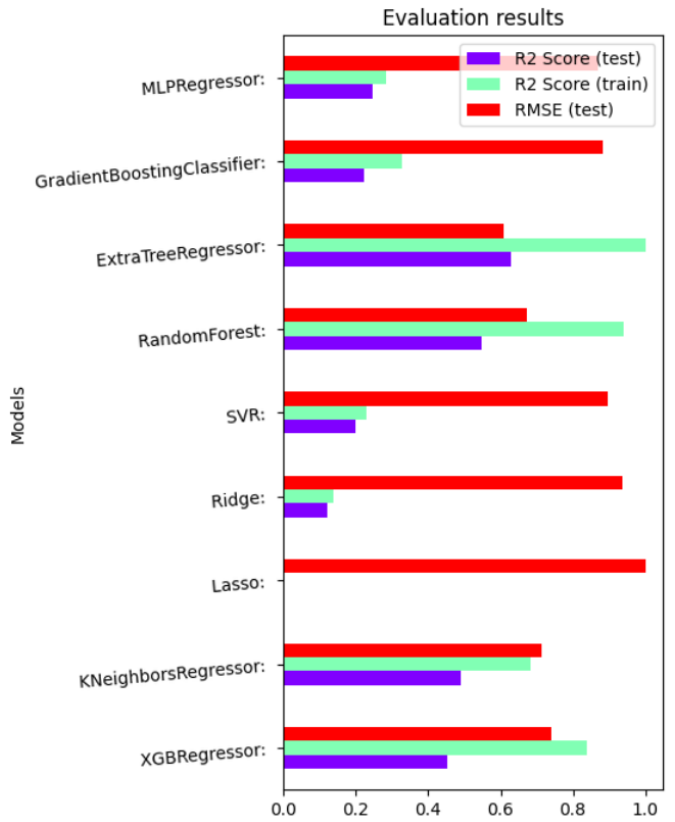
Figure 2. Root Mean Square Error (RMSE) and R2 scores of multiple